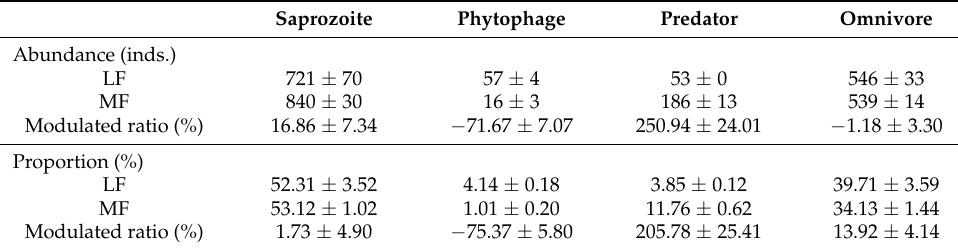
Table 4. Effects of mixed forest on the abundance and composition of functional groups. Saprozoite Phytophage Predator Omnivore Abundance (inds.) LF 721 ± 70 57 ± 4